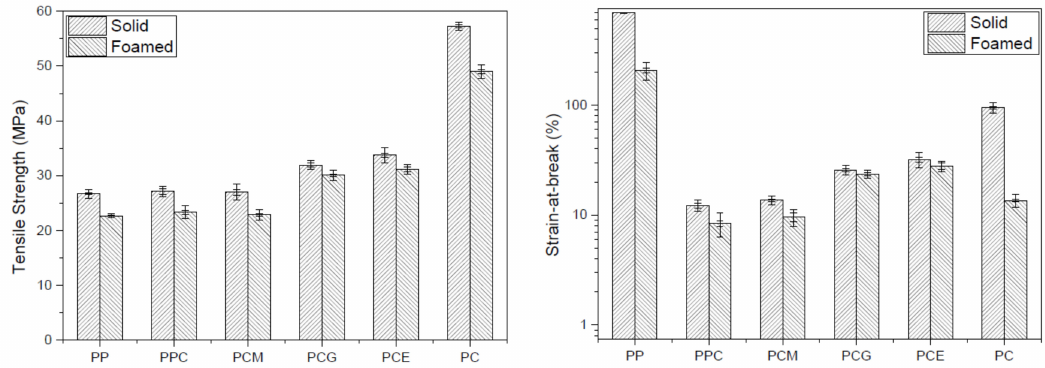
Figure 3. The tensile strength ( a ) and strain-at-break ( b ) of the molded solid and foamed PP/PC